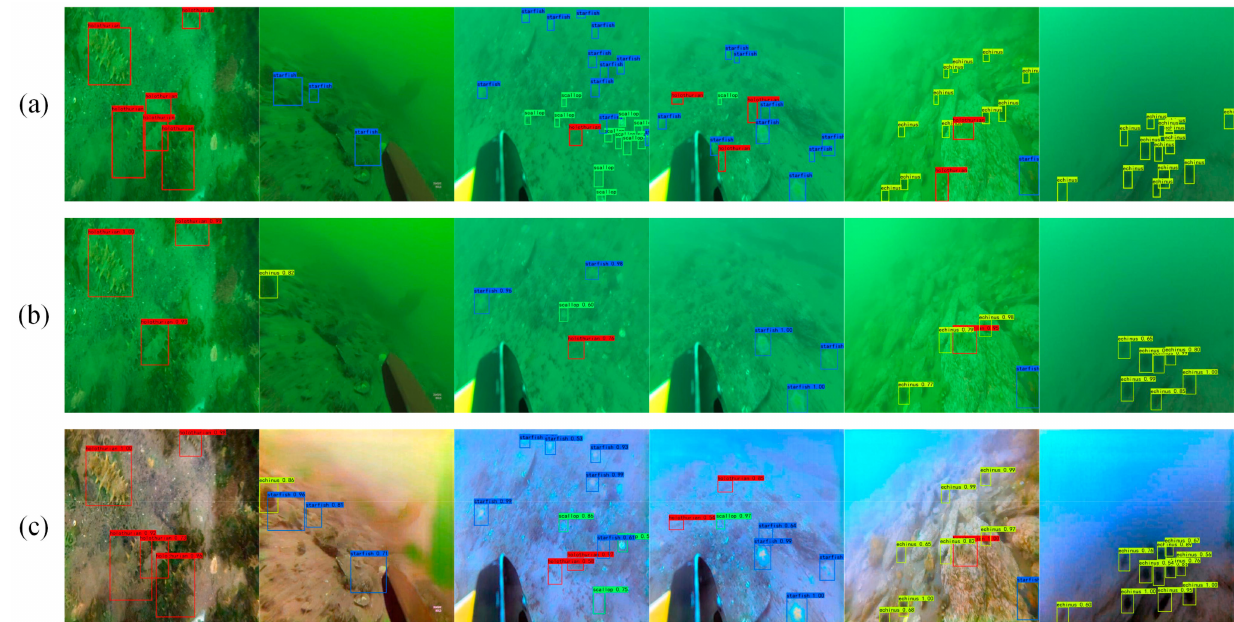
Figure 8. Underwater object detection results before and after enhancement. ( a ) Results with labels. ( b ) Results before enhancement. ( c ) Results after enhancement. Red boxes represent holothurians, blue boxes represent starfishes, yellow boxes represent echinus, and green boxes represent